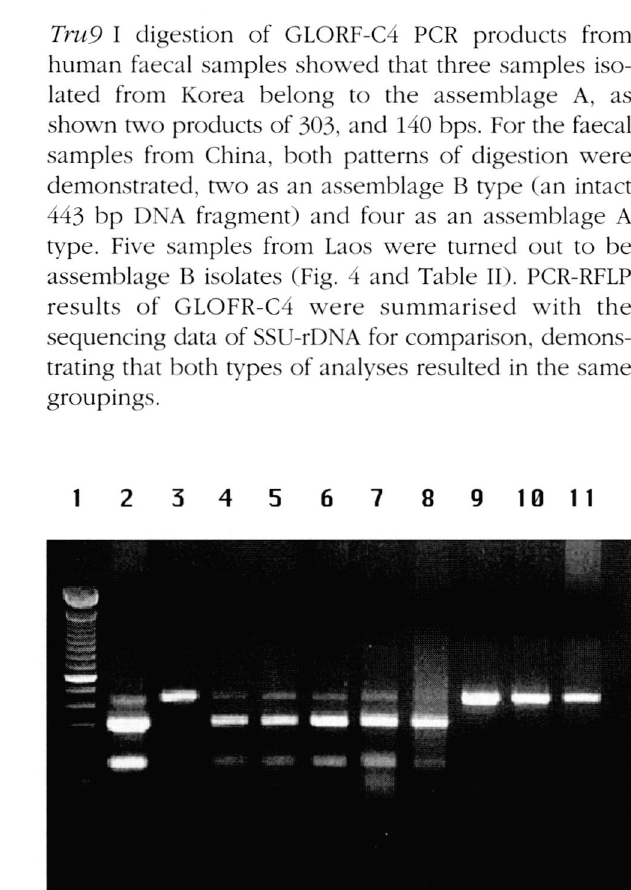
Table II. - Summary' of the faecal samples used in RFLP